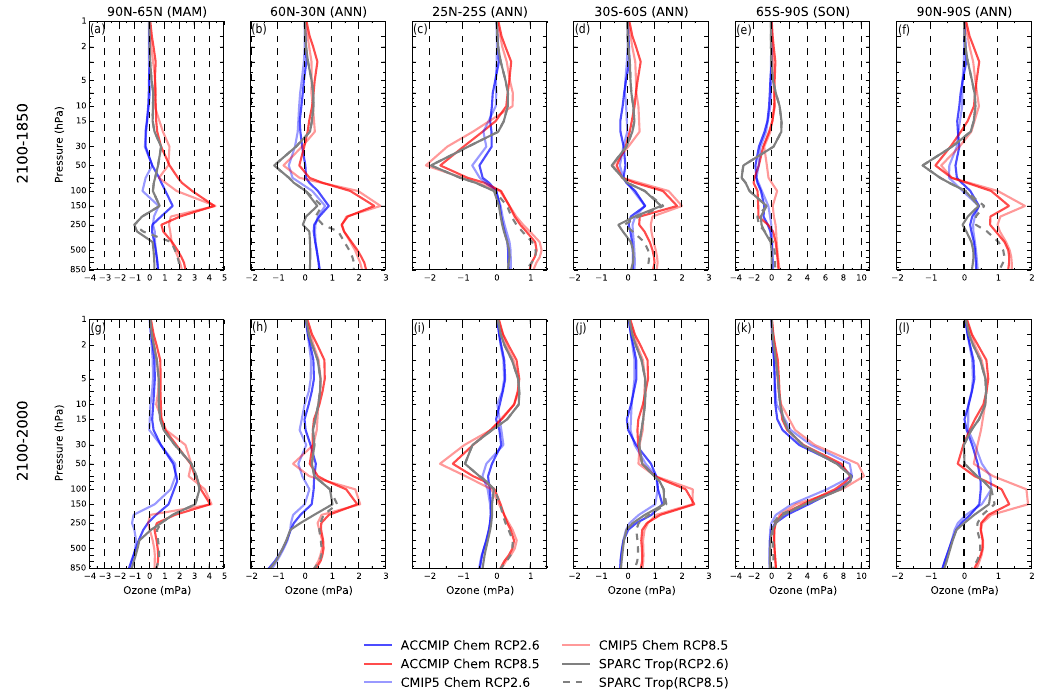
Figure 5. Vertically resolved ozone change between 2100 and 1850 ( a to f ), and 2100 and 2000 ( g to l ) time slices. Figures (a) – (g) are for Arctic boreal spring mean, (b) – (h) and (d) – (j) for NH and SH midlatitudes annual mean respectively, (c) – (i) for tropical annual mean, (e) – (k) for Antarctic austral spring mean, and (f) – (l) for global annual